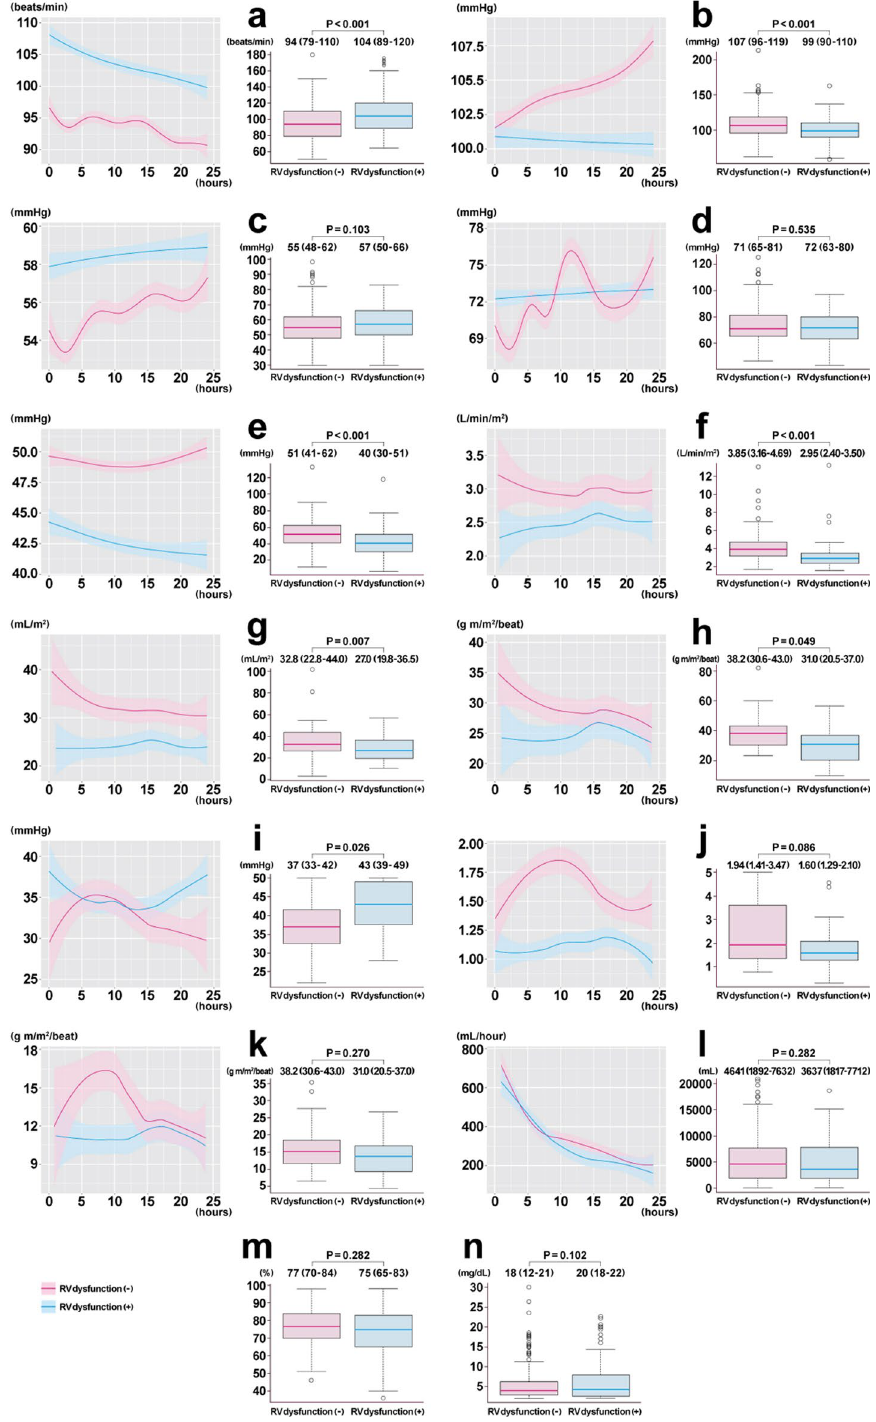
Figure 3. Comparison of hemodynamic parameters between patients with and those without RV dysfunction. (a) heart rate (n = 463), (b) systolic blood pressure (n = 463), (c) diastolic blood pressure (n = 463), (d) mean blood pressure (n = 463), (e) pulse pressure (n = 463), (f) CI (n = 132), (g) SVI (n = 97), (h) LVSWI (n = 48), (i) PAP (n = 63), (j) PAPi (n = 63), (k) RVSWI (n = 46), (l) infusion volume (n = 463), (m) ScvO 2 (n = 364), and (n) lactate levels (n = 463). Data within 24 hours of ICU admission were collected. Vital signs at the time of TTE were used for comparison. The maximum values were selected in other parameters. Blood pressure was measured via an arterial catheter or noninvasively. The CI and SVI were measured by an arterial catheter, pulmonary artery catheter, pulse index continuous cardiac output monitor, or noninvasive cardiac output monitoring system. The LVSWI and RVSWI were measured by a pulmonary artery catheter, and ScvO 2 was measured by a central venous catheter or pulmonary artery catheter. The PAPi was calculated using the following formula: (systolic PAP − diastolic PAP)/central venous pressure. CI cardiac index, SVI stroke volume index, LVSWI left ventricular stroke work index, PAP mean pulmonary artery pressure, PAPi pulmonary artery pulsatility index, RVSWI right ventricular stroke work index, ScvO 2 central venous oxygen